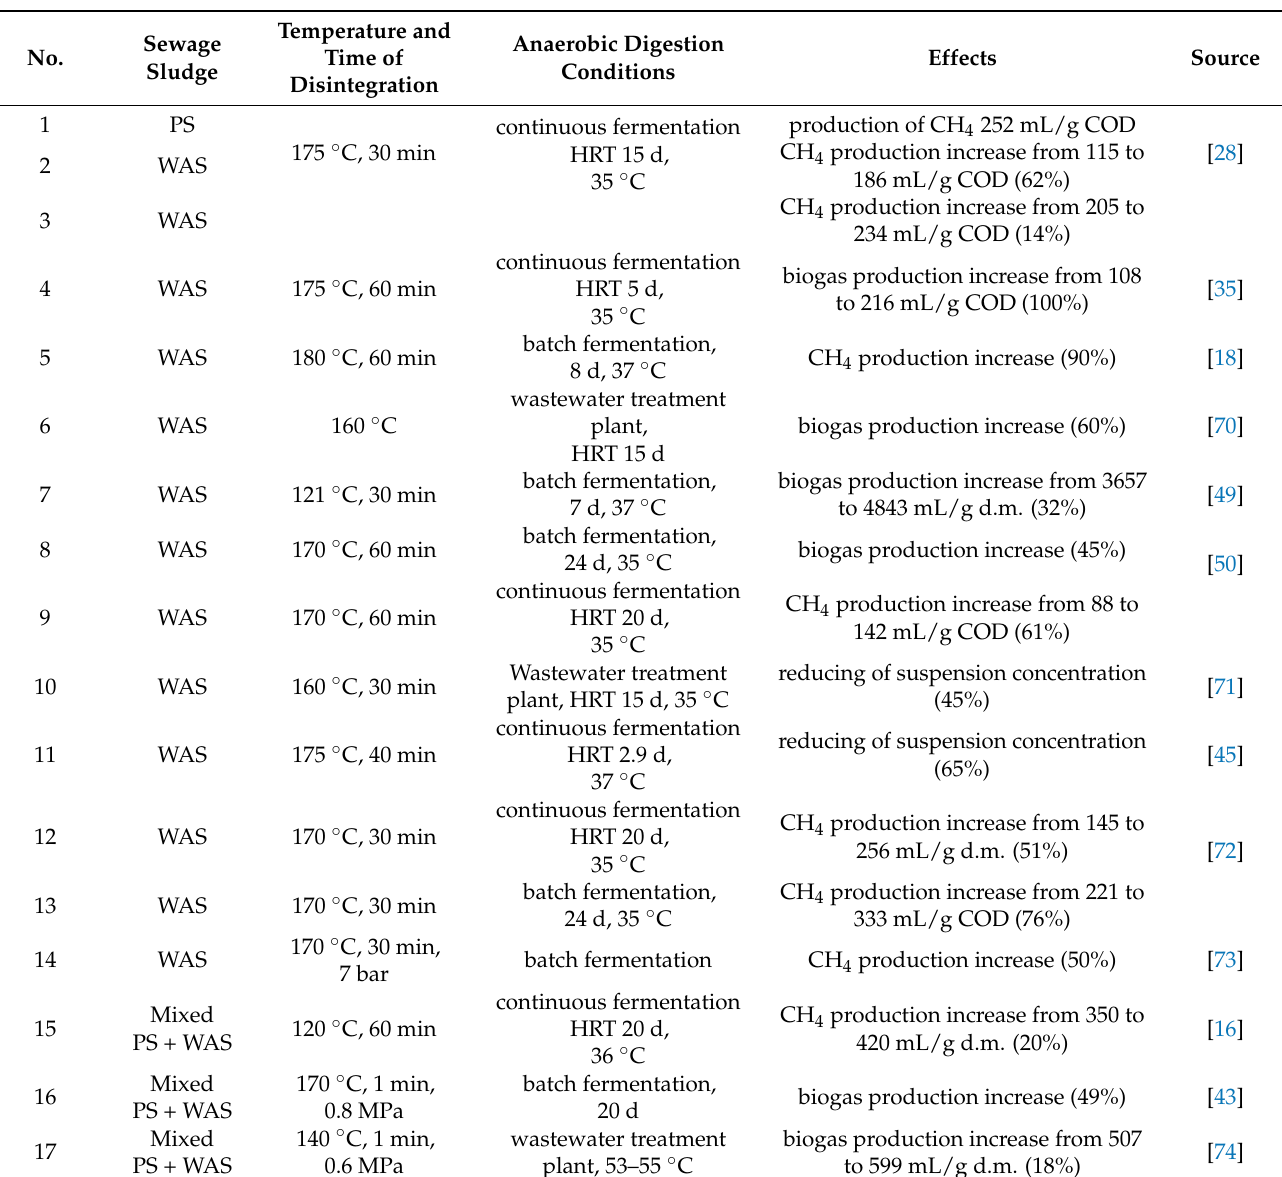
Table 2. Impact of high-temperature disintegration of sewage sludge on fermentation